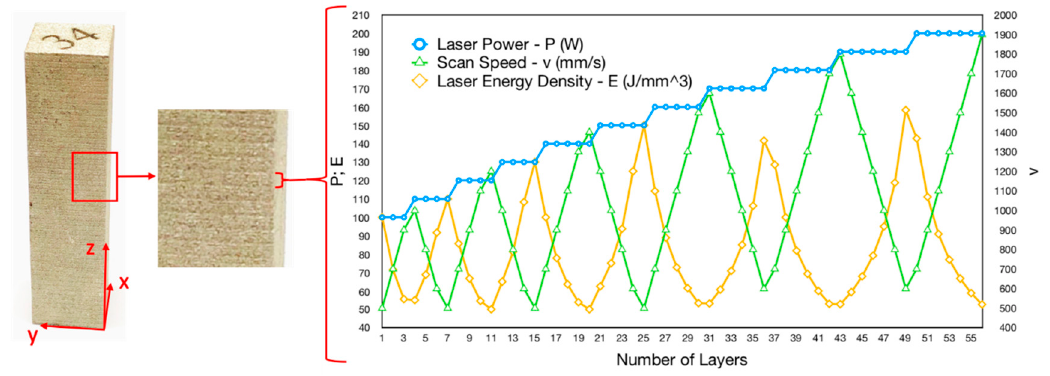
Figure 1. As-printed specimen and the applied parameters of each layer in a cycle.